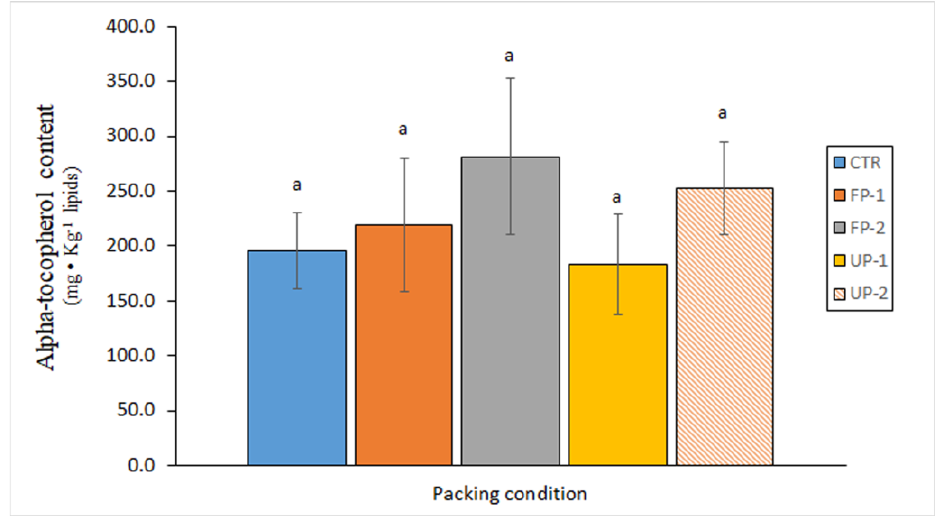
Figure 2. Determination of the alpha-tocopherol content in canned mackerel ( S. colias ) packed under different conditions. No significant differences ( p > 0.05) were detected (same “a” value for all samples) as a result of the packing medium employed. Sample abbreviations: CTR (Control), FP-1 and FP-2 (low- and high-concentrated F. spiralis extract), and UP-1 and UP-2 (low- and high-concentrated U. lactuca extract). Adapted from Barbosa et al.